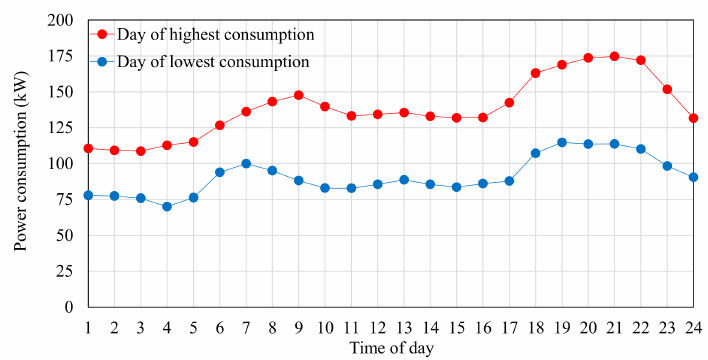
Figure 2. Example of profiles of hourly electricity consumption.